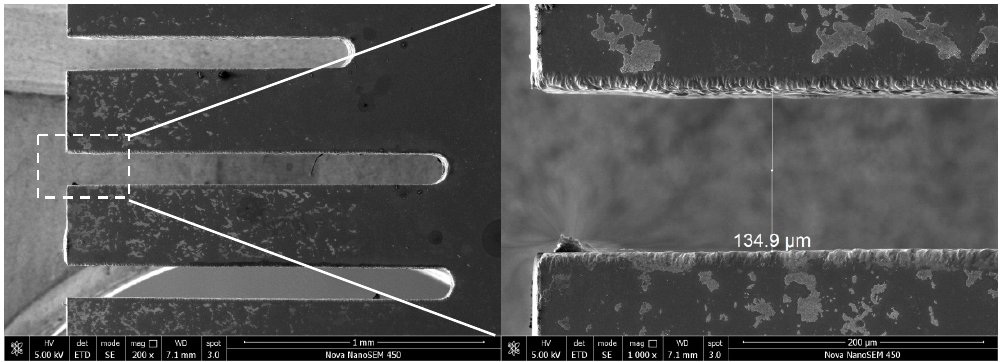
Figure 15. Long narrow slits on 300 μ m thick glass workpiece.